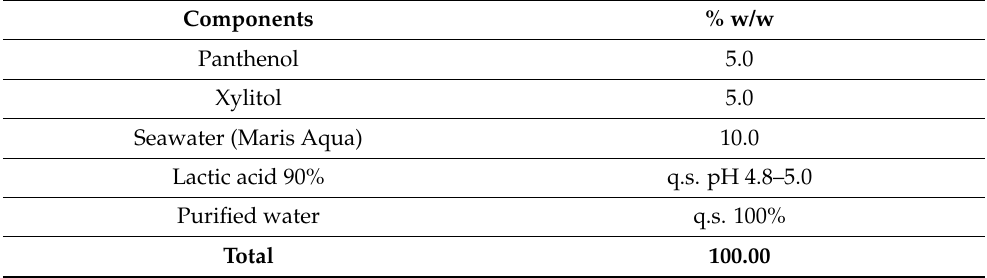
Qualitative–quantitative formulation of Tonimer Lab Panthexyl 800 nasal spray. w/w = weight/weight; q.s. = quantum